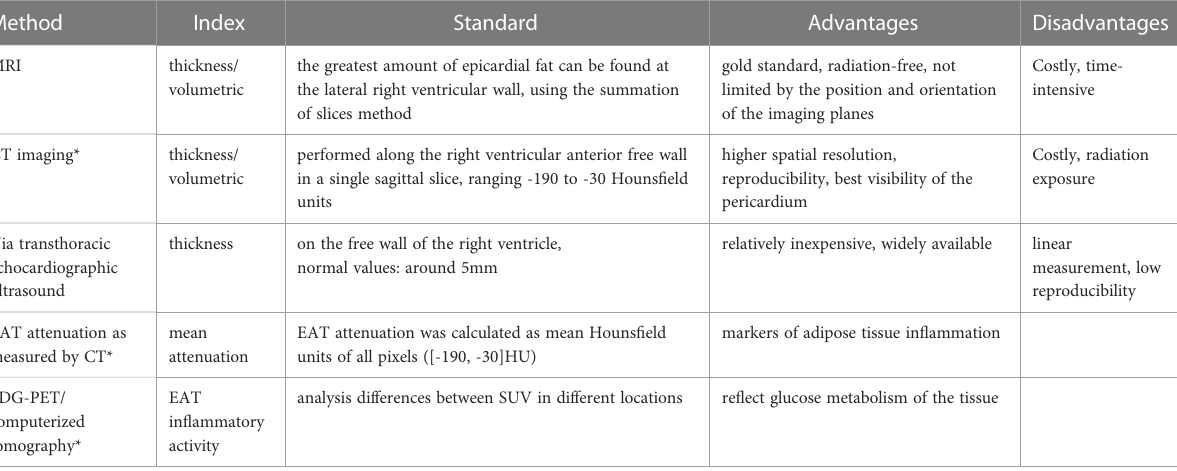
TABLE 3 Comparison of methods for detecting